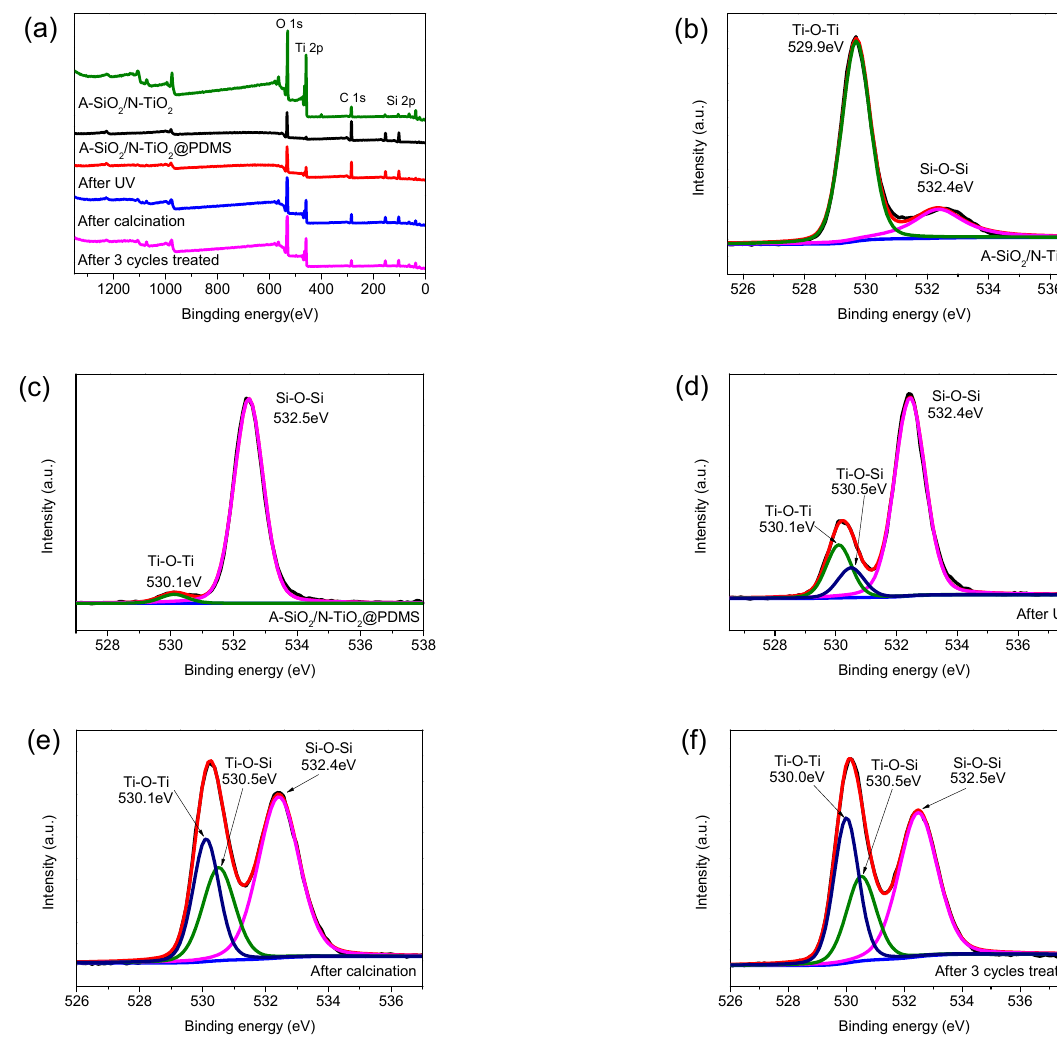
Figure 10. ( a ) Full-scan XPS spectra of A-SiO 2 /N-TiO 2 , A-SiO 2 /N-TiO 2 @PDMS, A-SiO 2 /N-TiO 2 @PDMS after UV irradiation; A-SiO 2 /N-TiO 2 @PDMS after calcination at 400 °C; and A-SiO 2 /N-TiO 2 @PDMS after three cycles of UV irradiation and calcination. ( b – f ) Narrow-scan spectra of O 1s in the above spectra.